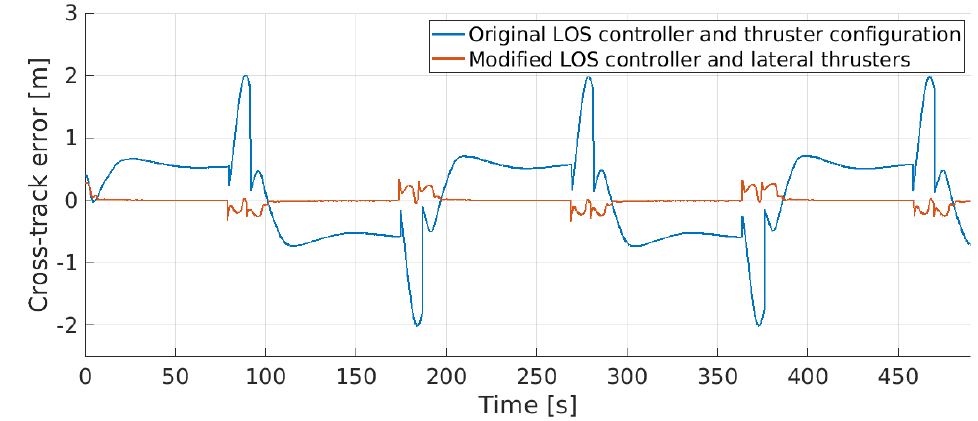
Figure 18. Simulation results for cross-track error during lawn mower pattern path following employing the vehicle’s original configuration—SPARUS II and the modified configuration—ALICE.